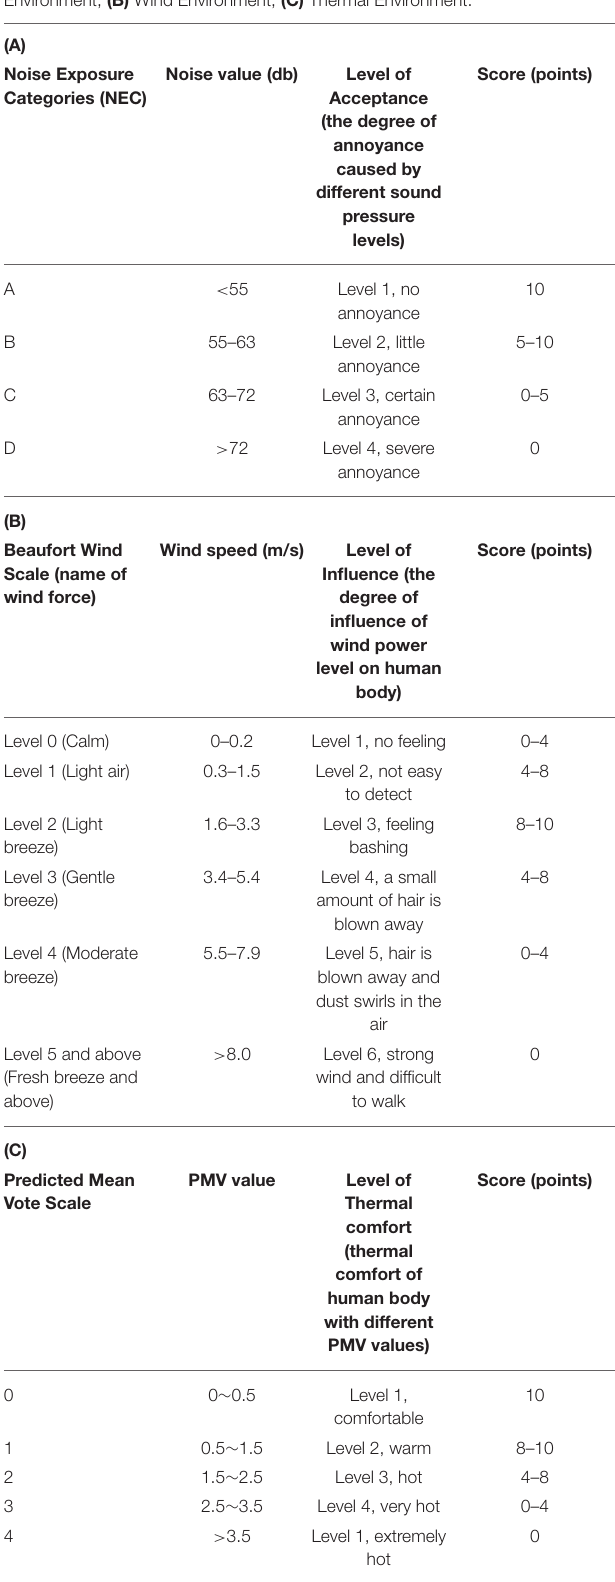
TABLE 2 | Quantitative evaluation of different environment: (A) Acoustic Environment, (B) Wind Environment, (C) Thermal